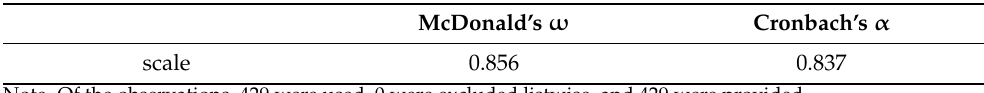
Table 7. Factor Covariances.